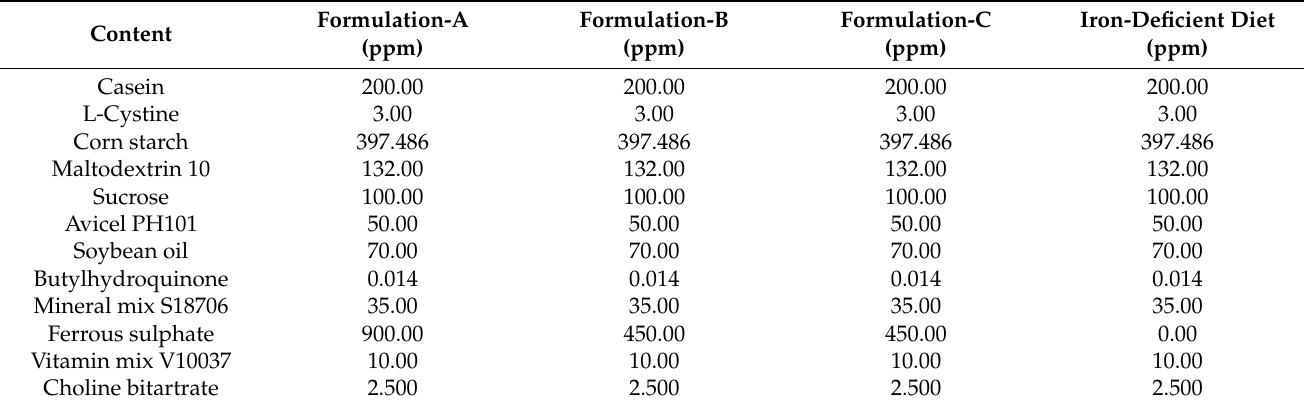
Table 1. Nutritional composition of diets (modified AIN 93G) fed to the